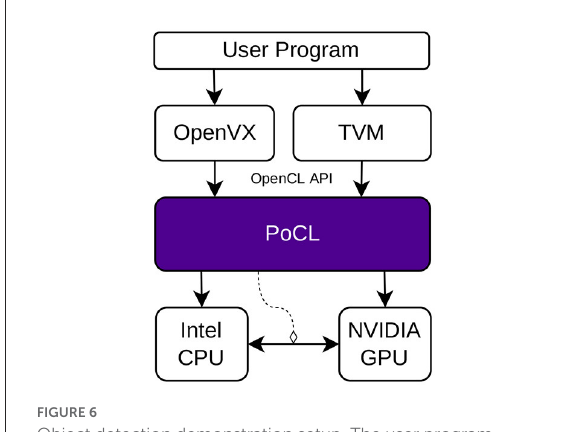
FIGURE6 Object detection demonstration setup. The user program defines the application in standard OpenVX and TVM library calls, which internally share the OpenCL context with each other.